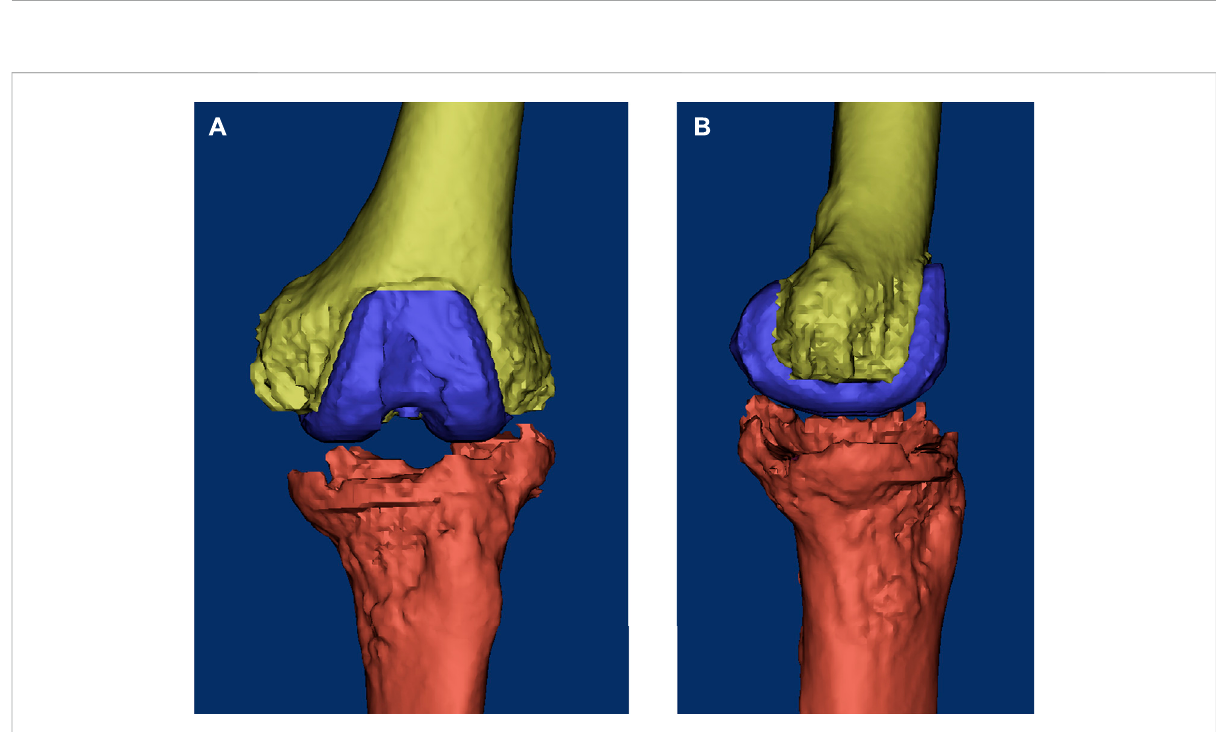
FIGURE 2 Three-dimensional reconstructed image of the knee based on the CT data before surgery. (A) Coronal view; (B) sagittal